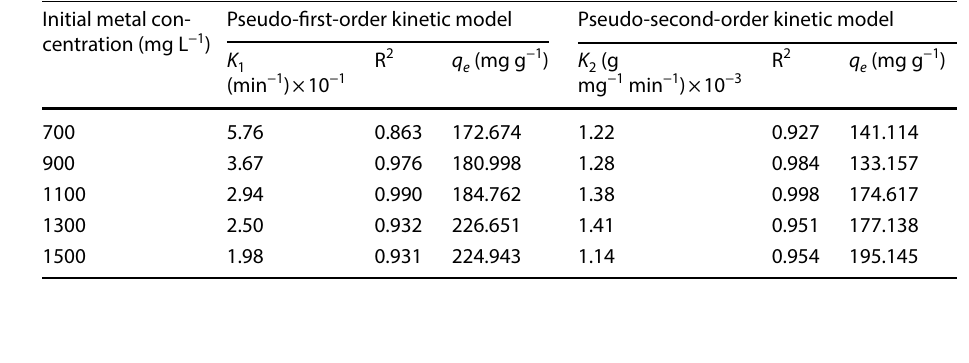
Fig. 6 Adsorption kinetics of Pb (II) into nano- CaCO ferent concentrations